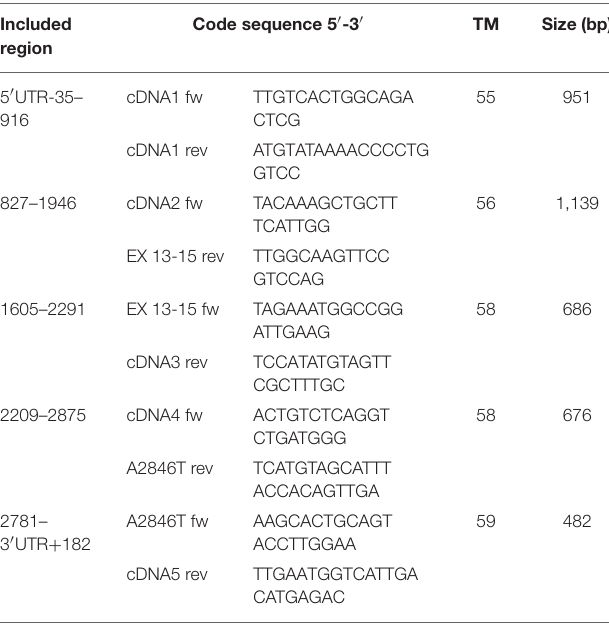
TABLE 1 | Primers used in the DPYD cDNA amplification and sequencing (RefSeq: NM_000110, Transcript ID: ENST00000370192.7). Included